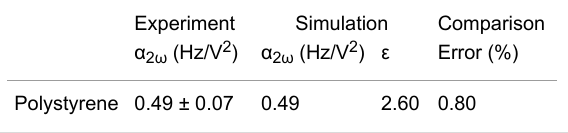
Table 1: Experimental data and simulations for a typical reference polystyrene sample, using z = 30.14 nm, tip-calibration parameters (28 nm, 15°), and average particle diameter = 382 nm. A particle permittivity of 2.6 fits simulations with 0.8%